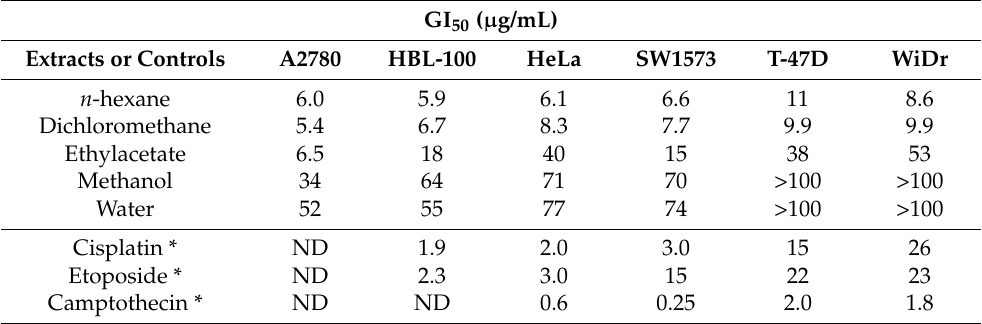
Table 3. Antiproliferative activity of extracts from the aerial parts of S. pachyphylla